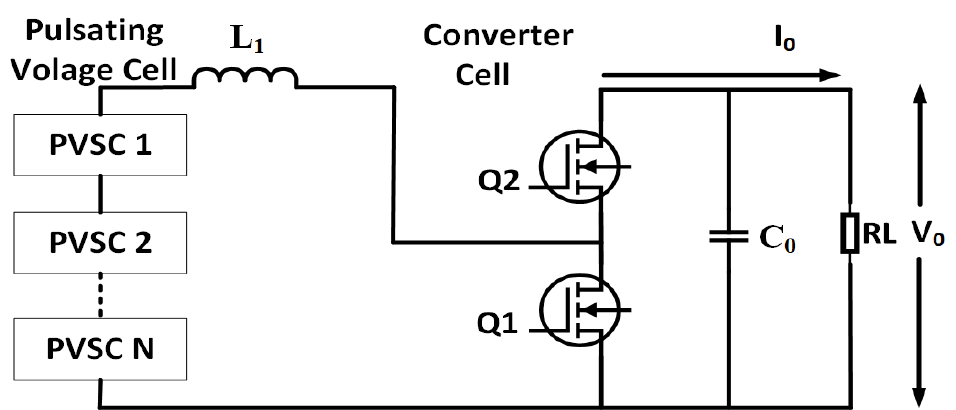
Figure 14. Topology structure of multi-source cell.